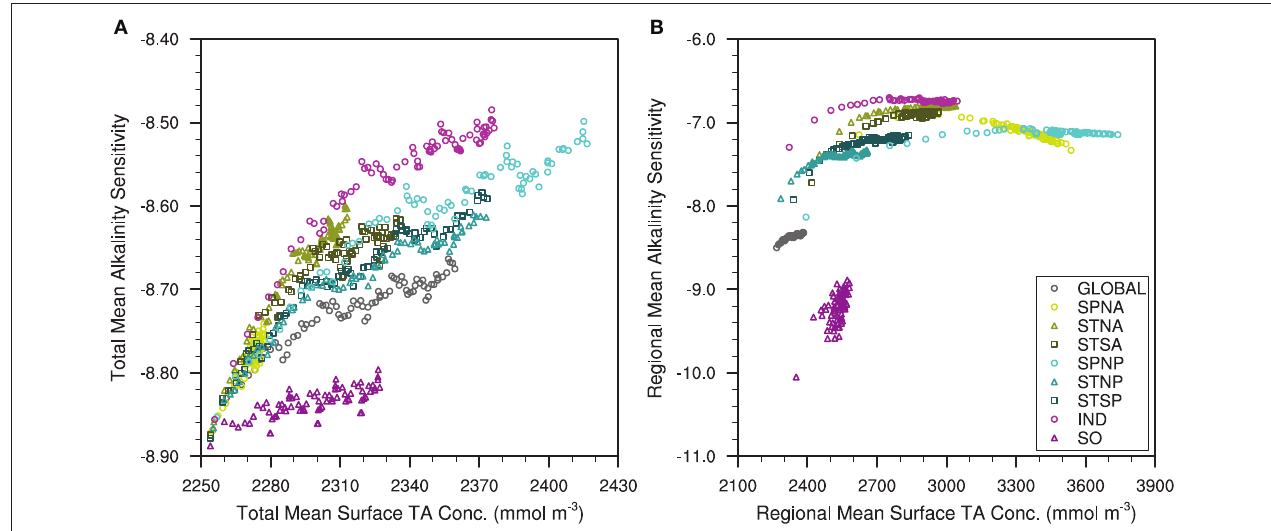
FIGURE 8 | (A) The total annual mean surface alkalinity sensitivity against the total annual mean surface total alkalinity and (B) the regional annual mean surface alkalinity sensitivity against the regional annual mean surface total alkalinity for the global and different regional ocean alkalinity enhancement